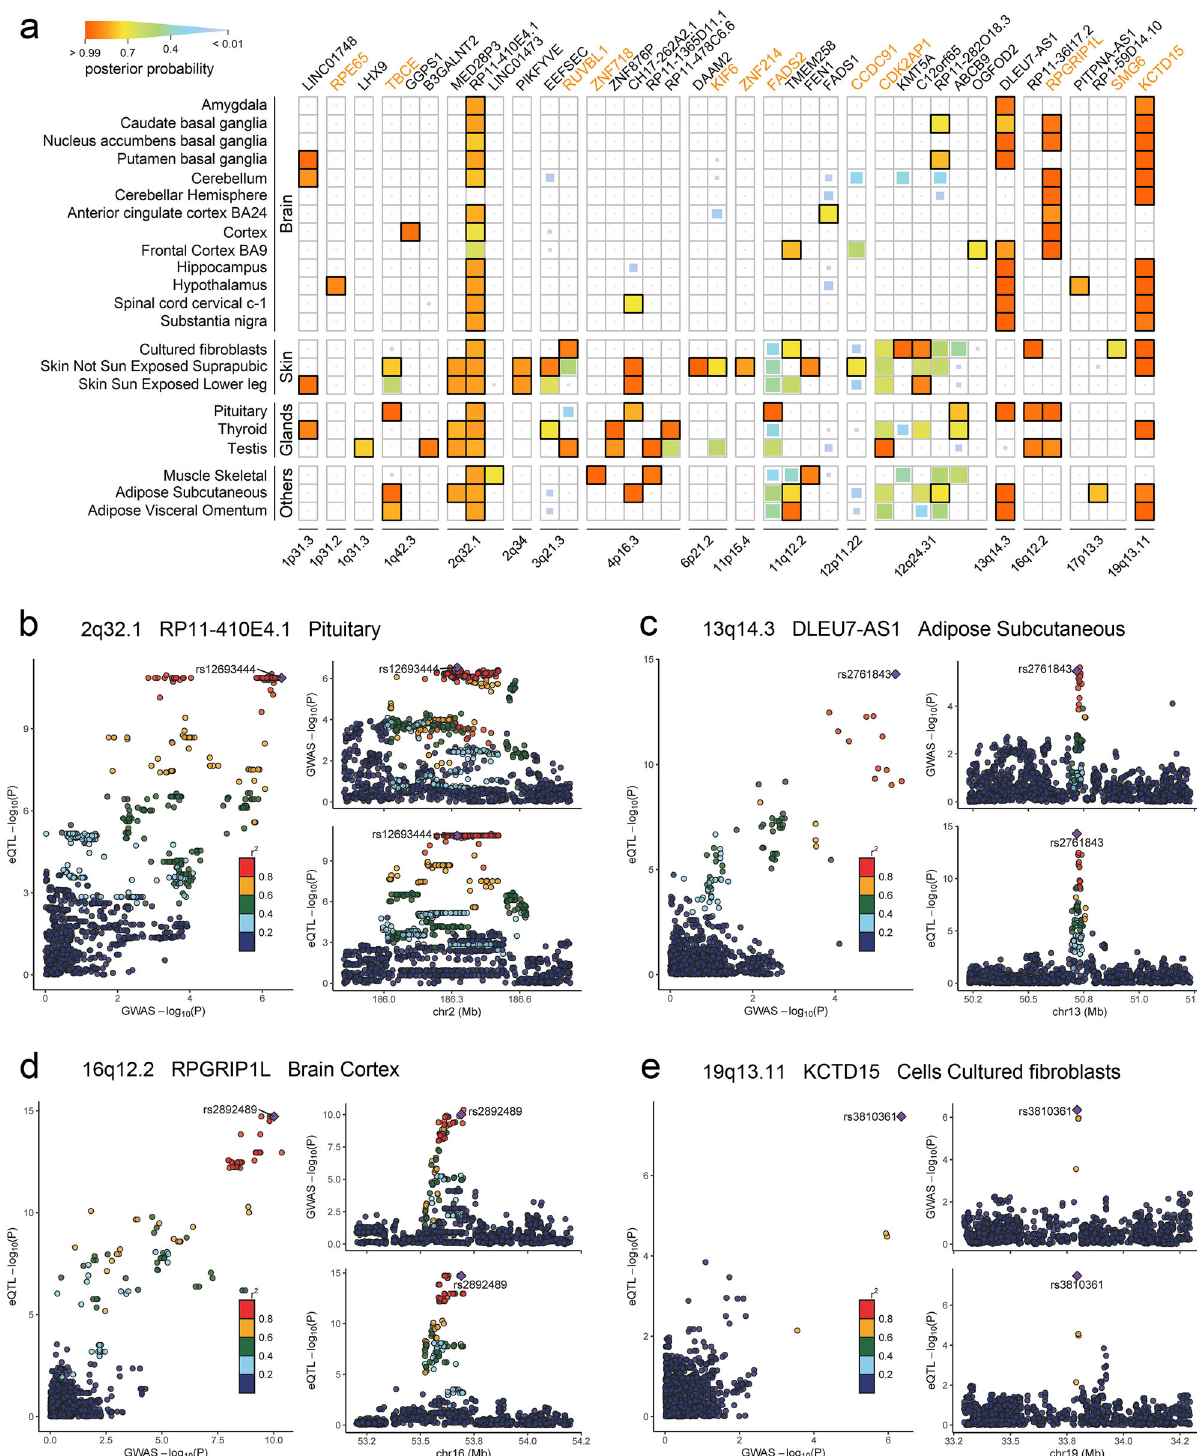
Fig. 7 | Colocalization analysis of C-GWAS signi fi cant fi ndings. Colocalization analysis was carried out for the 56 loci from C-GWAS in 22 tissues from GTEx. a Posterior probabilities in the heatmap are indicated using the box size and the gradienceincolor(posteriorprobabilities>0.7insolidboxes).Closestgenestothe regional lead SNPs are indicated using orange text. Four examples of eQTL